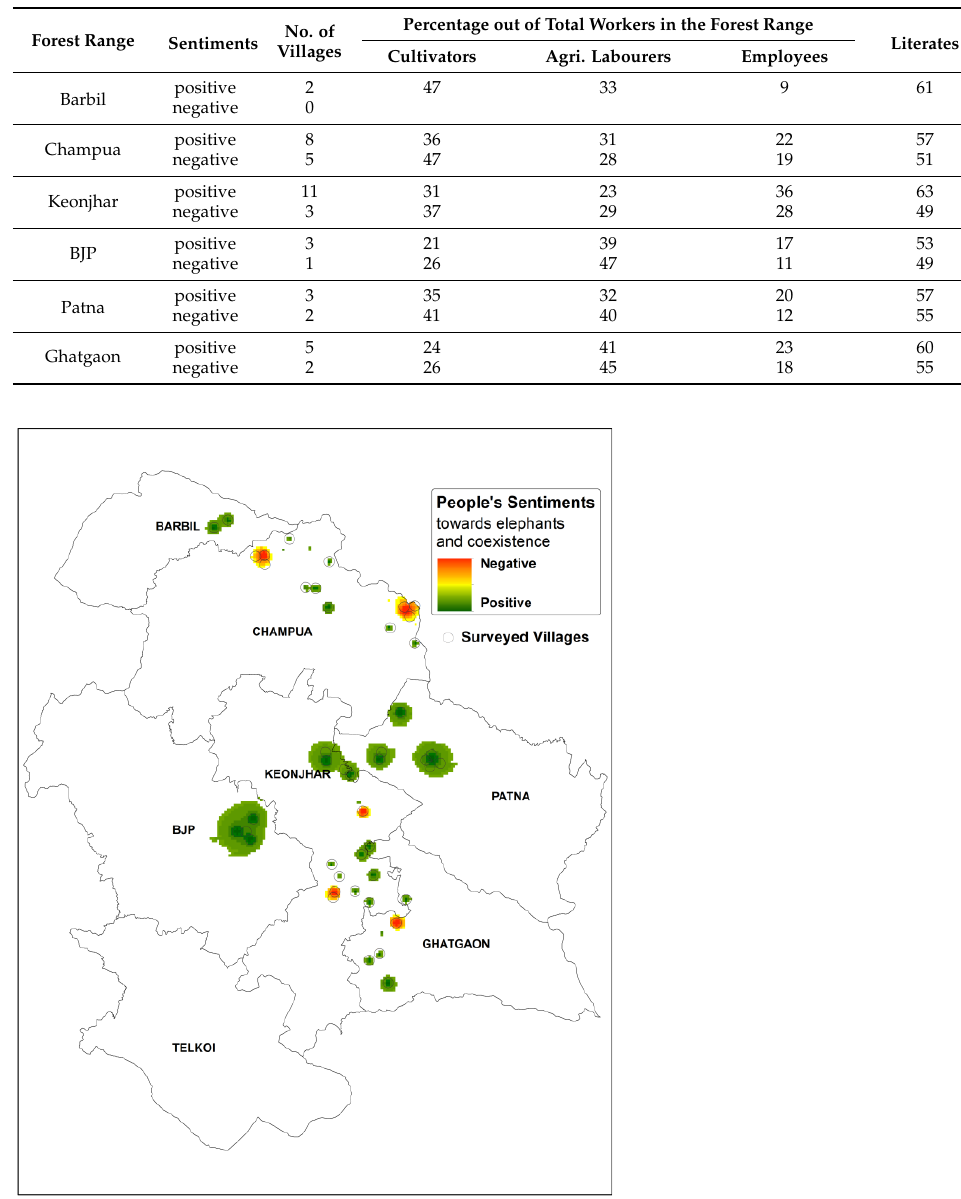
Table 2. People’s sentiments classified by demographic categories within the forest ranges impacted by human-elephant conflict of the Keonjhar district.